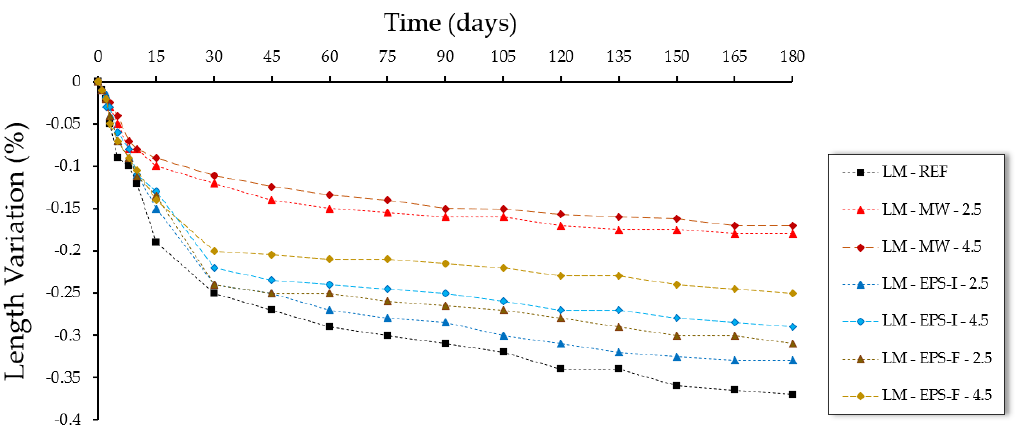
Figure 13. Shrinkage evolution. Length variation (%) during setting time (days).